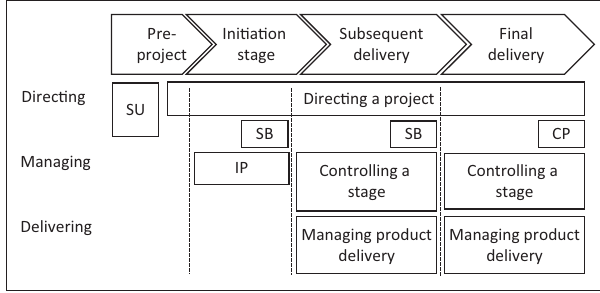
FIGURE 1: Projects in Controlled Environments process